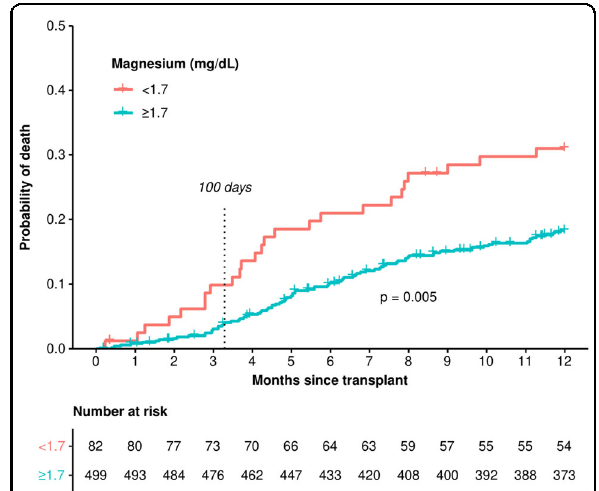
Fig. 2 Overall survival of patients with diffuse large B-cell lymphoma undergoing autologous stem cell transplant by premyeloablative serum magnesium level between 1998 and 2020. Log-rank test p = 0.005.